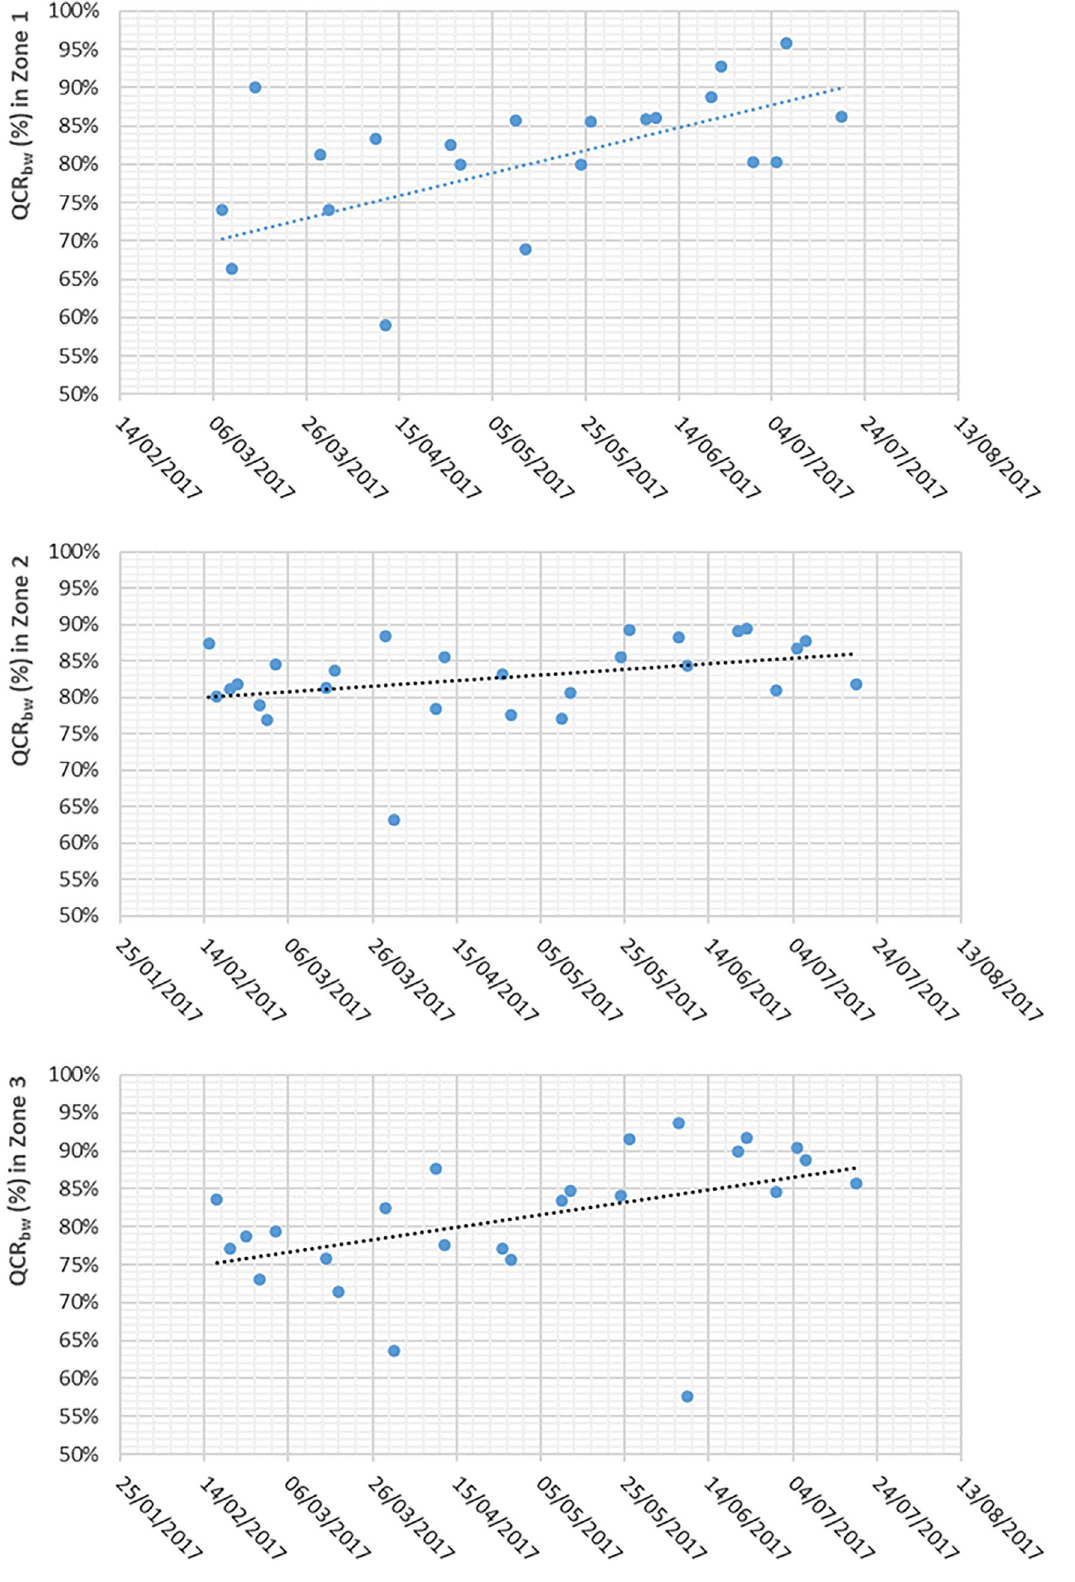
Figure 2. Variation of QCR bw (%) over time in Zone 1, 2 and